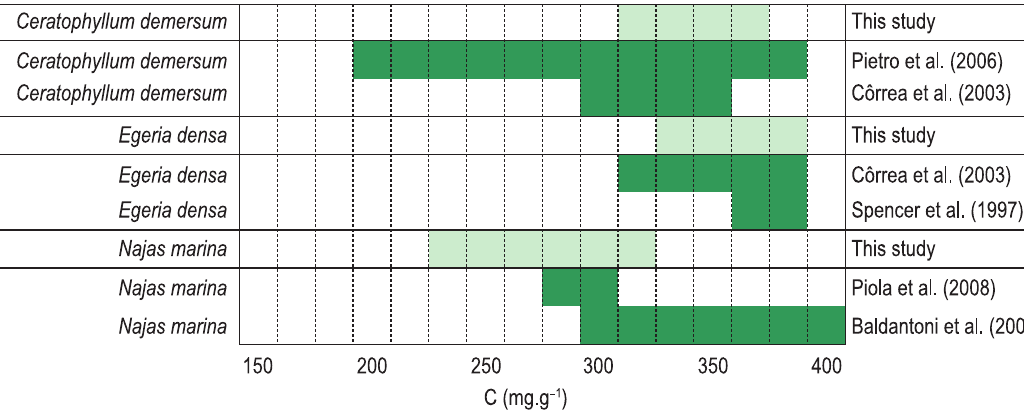
Figure 6. Carbon content in macrophytes, expressed as milligram per gram of dry matter (mg.g -1 ), using data from this study and from literature.